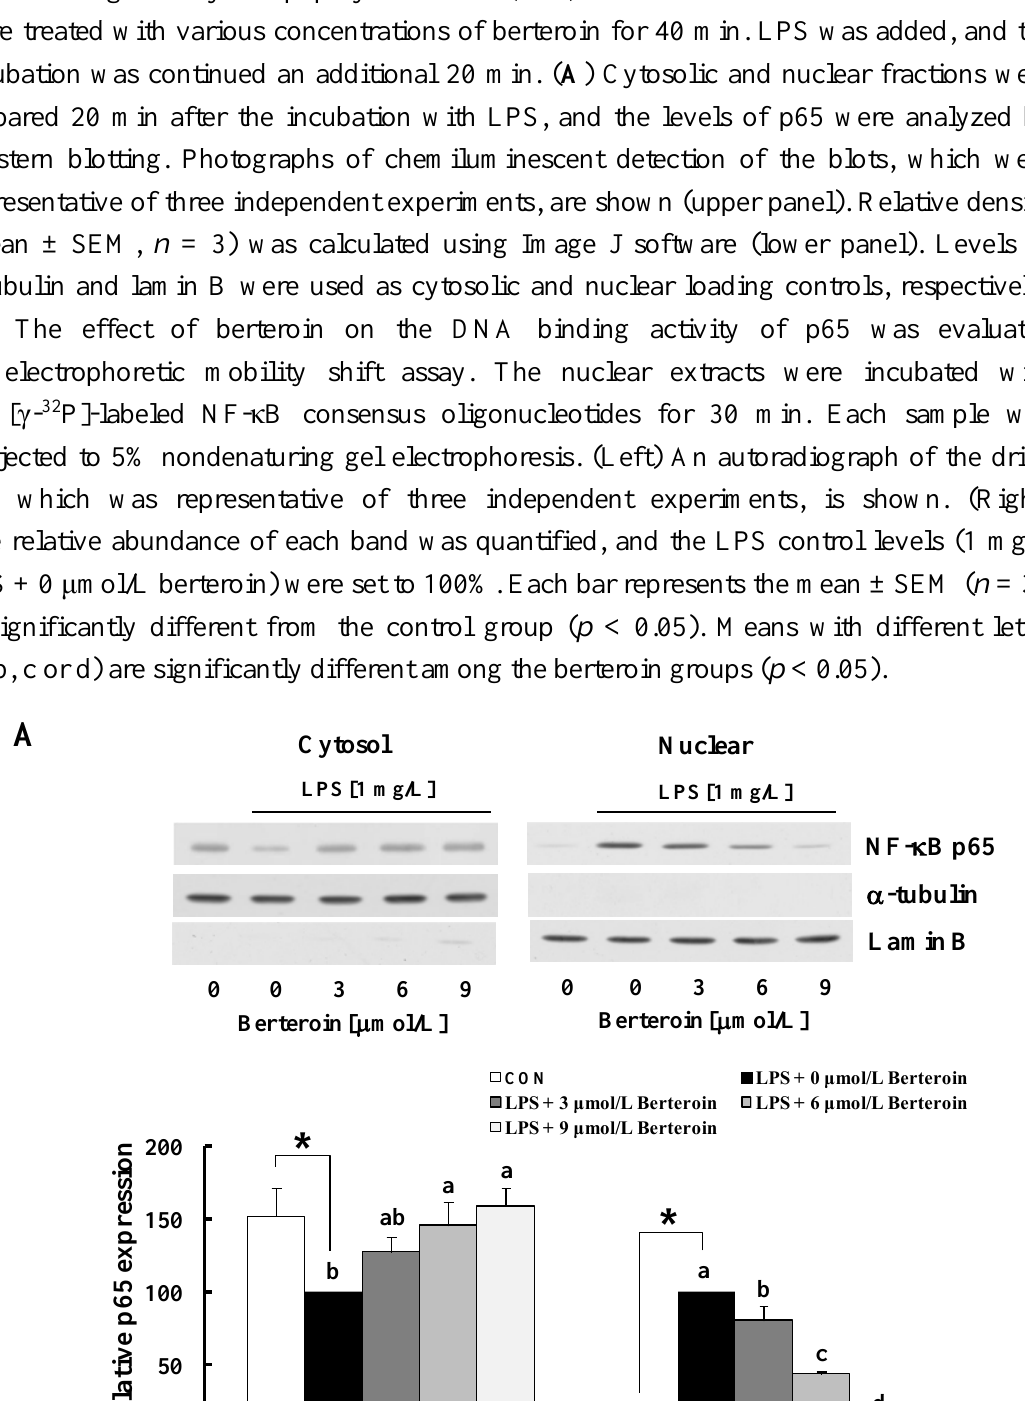
Figure 4. Berteroin inhibits nuclear factor (NF)-κB translocation to the nucleus and its DNA binding activity in lipopolysaccharide (LPS)-stimulated Raw 264.7 cells. The